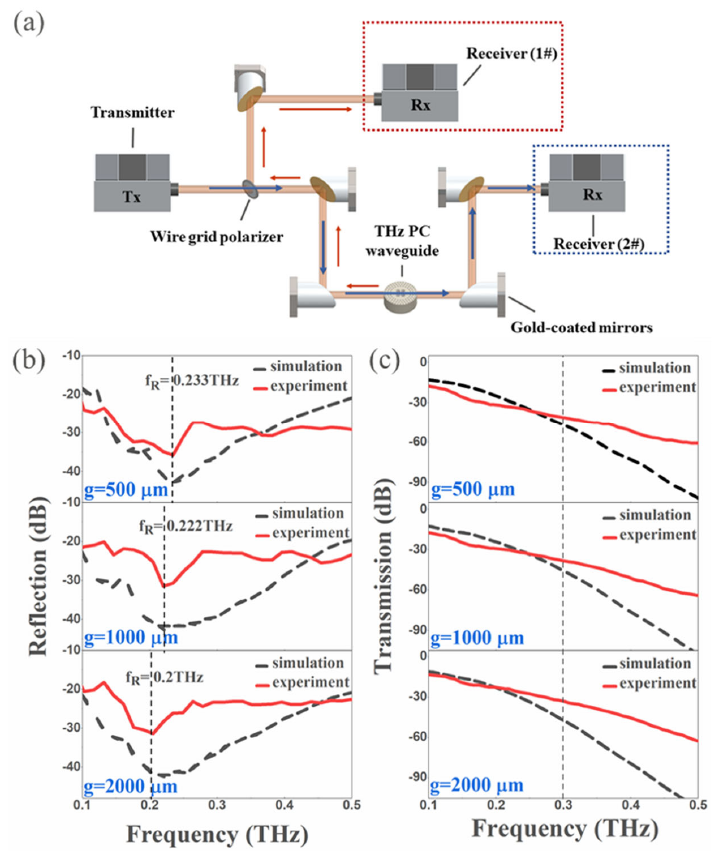
Figure 4. ( a ) Optical path for the THz-TDS measurement setup, the above experiments are performed in dry air. ( b ) The simulated and experimental reflection spectra for the THz PC waveguide with the gap distance ( g ) set as 500 μ m, 1000 μ m, and 2000 μ m, respectively. ( c ) The simulated and experimental transmission spectra for the THz PC waveguide with the gap distance ( g ) set as 500 μ m, 1000 μ m, and 2000 μ m, respectively.